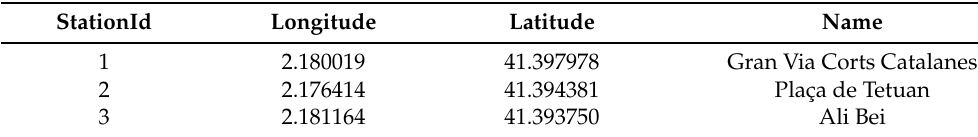
Table 3. Example of stations’ information.